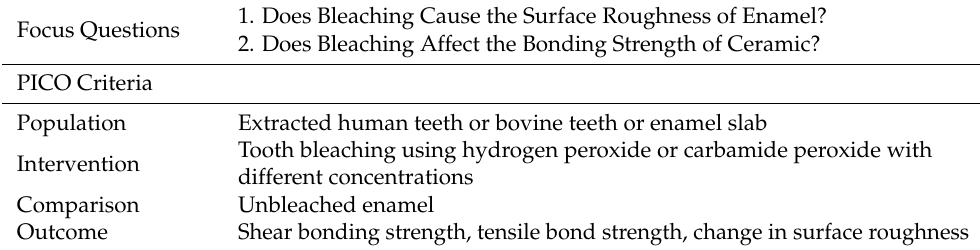
Table 1. Focus questions and PICO criteria.